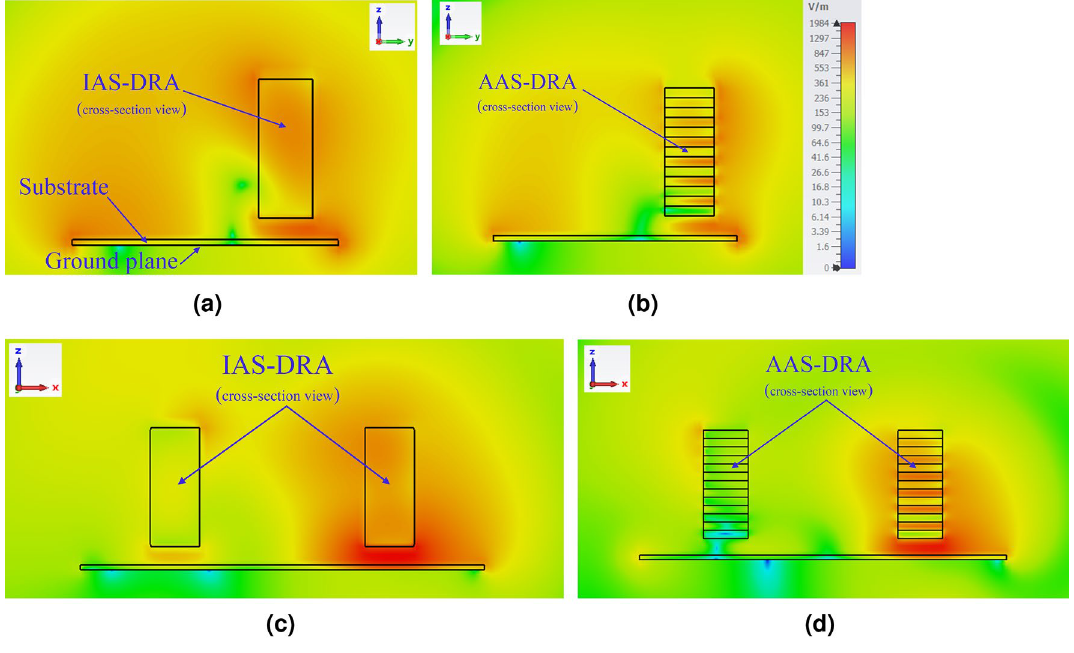
Figure 3. Simulated electric field distribution of annular sector DR. ( a ) IAS ( x -direction), ( b ) AAS ( x -direction), ( c ) IAS ( y -direction), and ( d ) AAS ( y -direction) at 6.3 GHz.